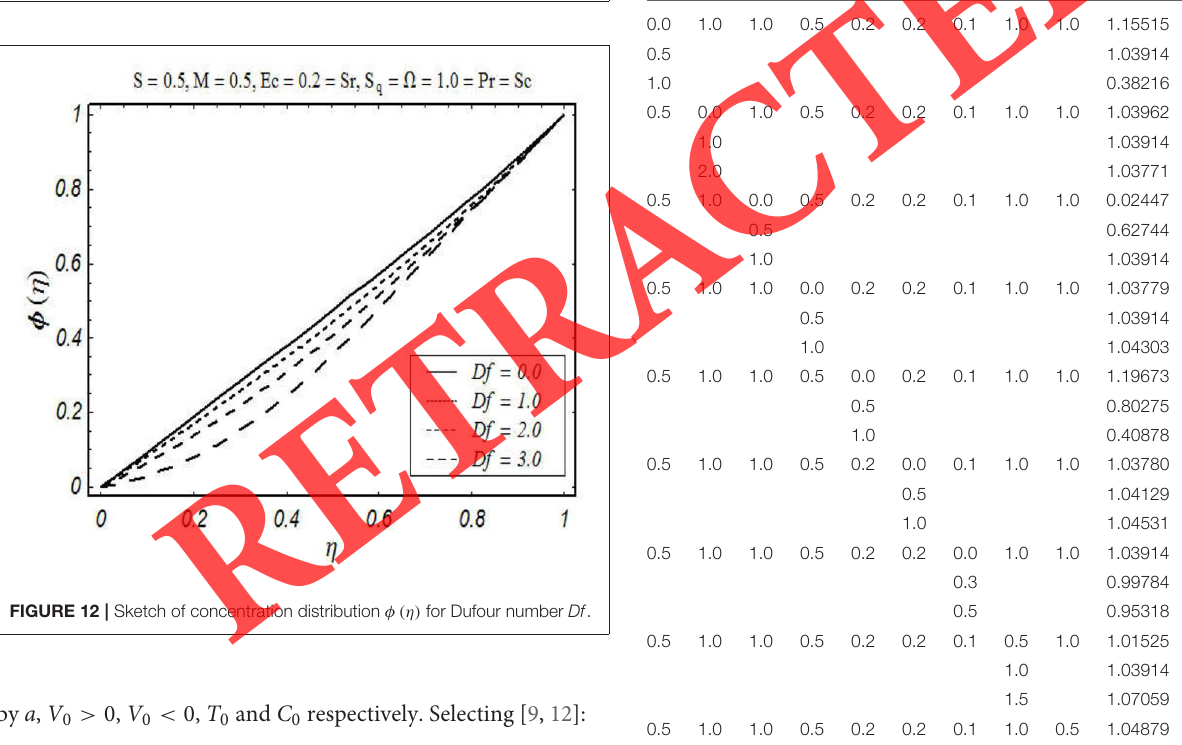
FIGURE 12 | Sketch of concentration distribution φ (η) for Dufour number Df .